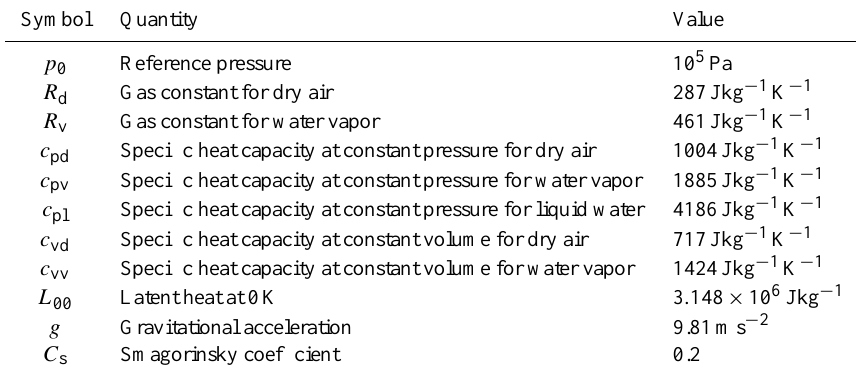
Table 1. Physical